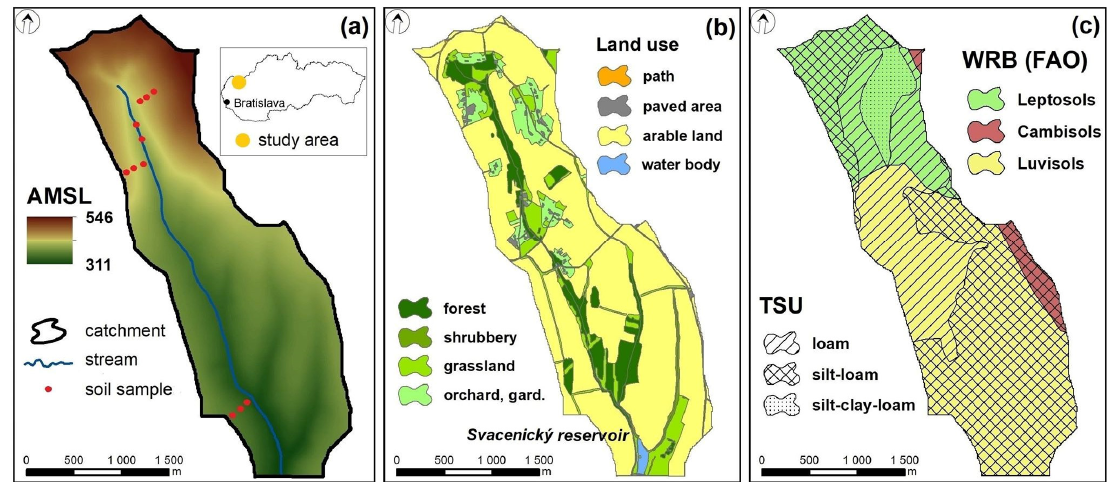
Figure 2. The characteristics of the Svacenický Creek catchment study area: ( a ) Relief, soil samples and location in the Slovak Republic; ( b ) land use; ( c ) textural soil unit (TSU) and World Reference Base (WRB(FAO)).